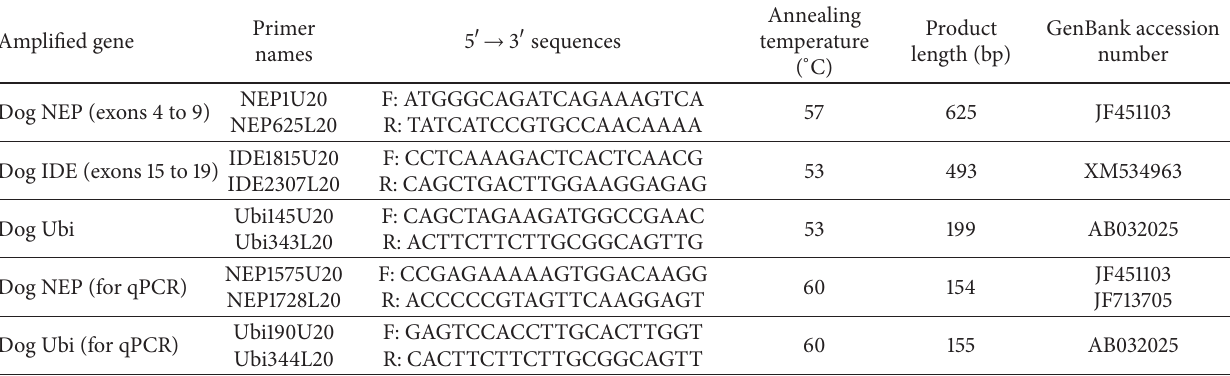
Table 2: Pairs of primers used for